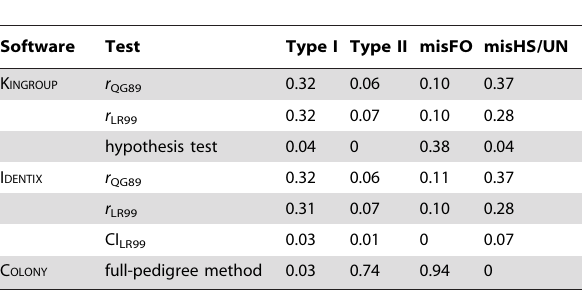
Table 2. Errors associated with relatedness estimates based on the results for the simulated